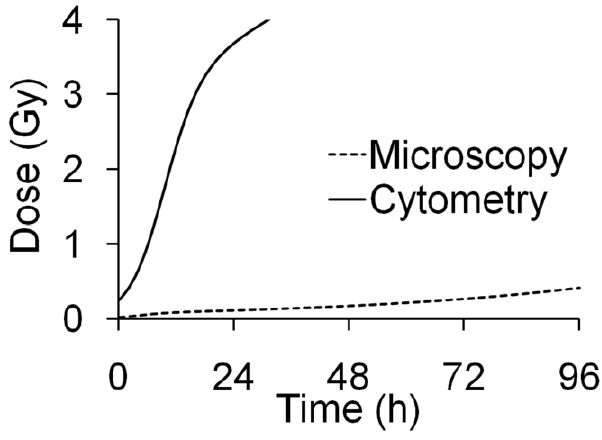
Figure 5. Minimum detectable dose for microscopic vs. flow cytometric c -H2AX biodosimetry over 96 hours post exposure.